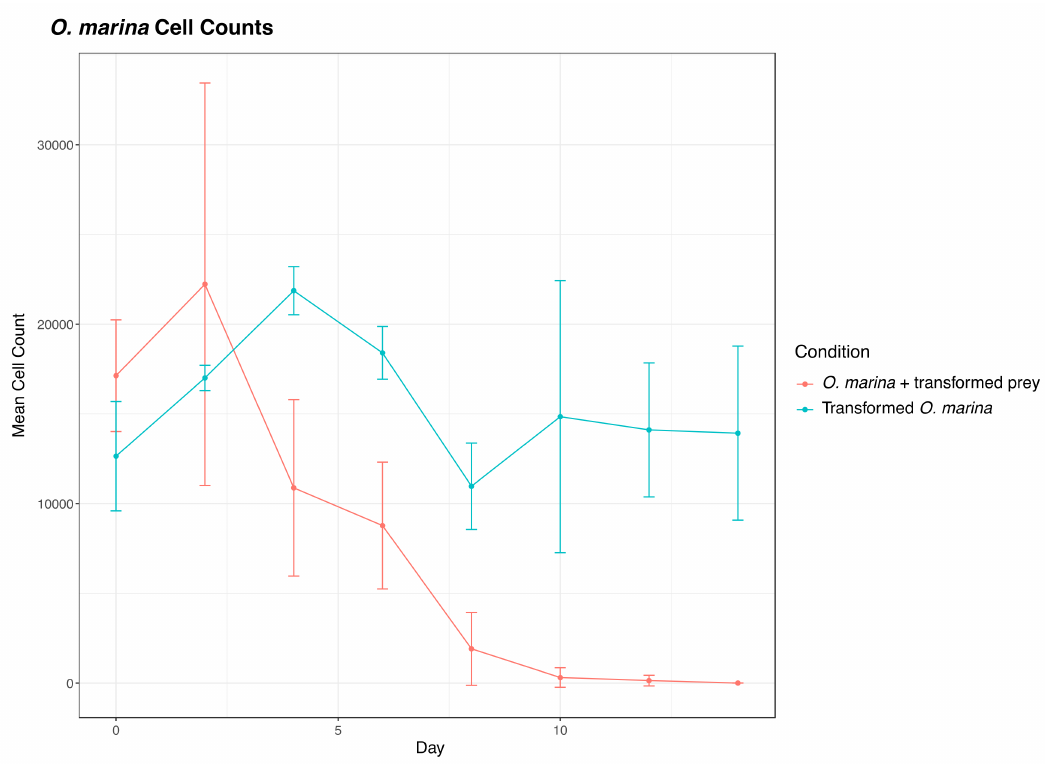
Figure 5. Comparison of O. marina cell counts under 225 µ g / mL rifampin between wild-type O. marina fed transformed D. tertiolecta (“ O. marina + transformed prey”) and transformed O. marina cells ( O. marina + arrO -N) fed wild-type D. tertiolecta . The marked di ff erence indicates that our observed O. marina transformation was not an artifact from D. tertiolecta transformation. The center values represent the means, with standard deviation as error bars from results of di ff erent pulse codes. Note that transformed O. marina stopped growing after 10 days because no additional prey was added to the culture since day